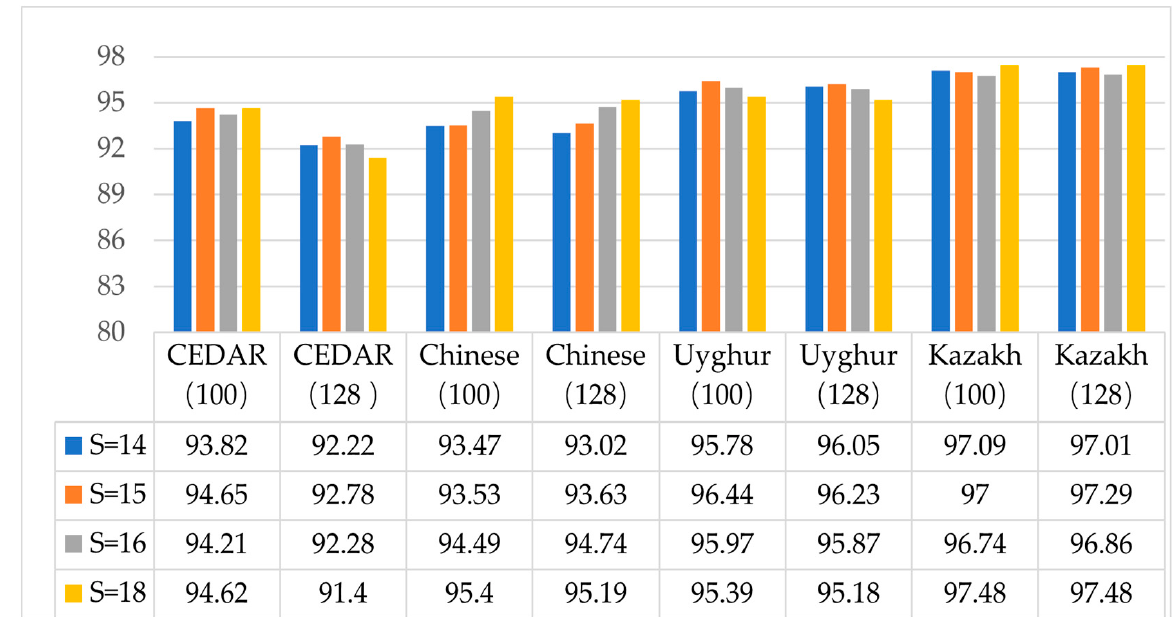
Figure 11. Recognition results of HOG features of different dimensions.